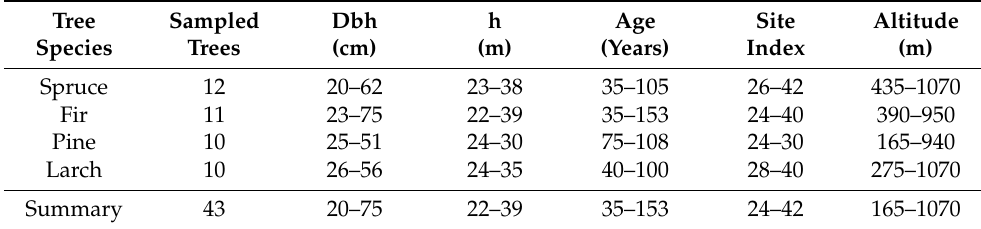
Table 1. Basic characteristics of the sampled trees and stands [24,25].